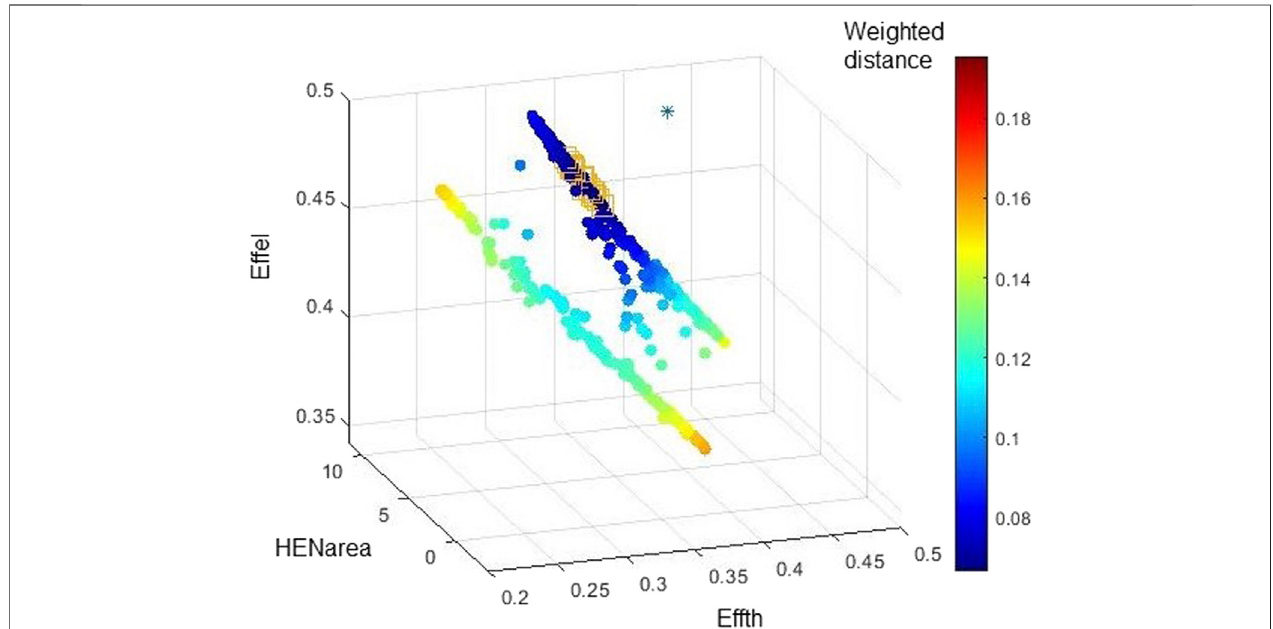
FIGURE 5 | Pareto front and sorting of solutions based upon the utopian point (star point).